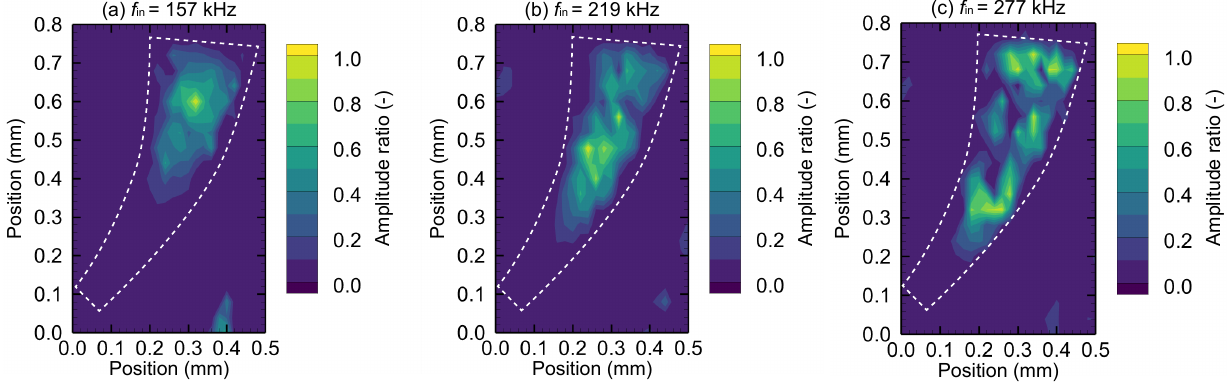
Figure 9. Experimental results of amplitude distribution in the xy plane for the miniaturized artificial cochlear sensory epithelium. Contours show the relative amplitude normalized by the maximum value of the oscillation amplitude when the driving force with the frequency of ( a – c ) was applied. Resonance positions indicated by the maximum amplitude are obtained for every resonance frequency. The device exhibits different resonance positions depending on the normal modes, and this tendency is observed in the numerical